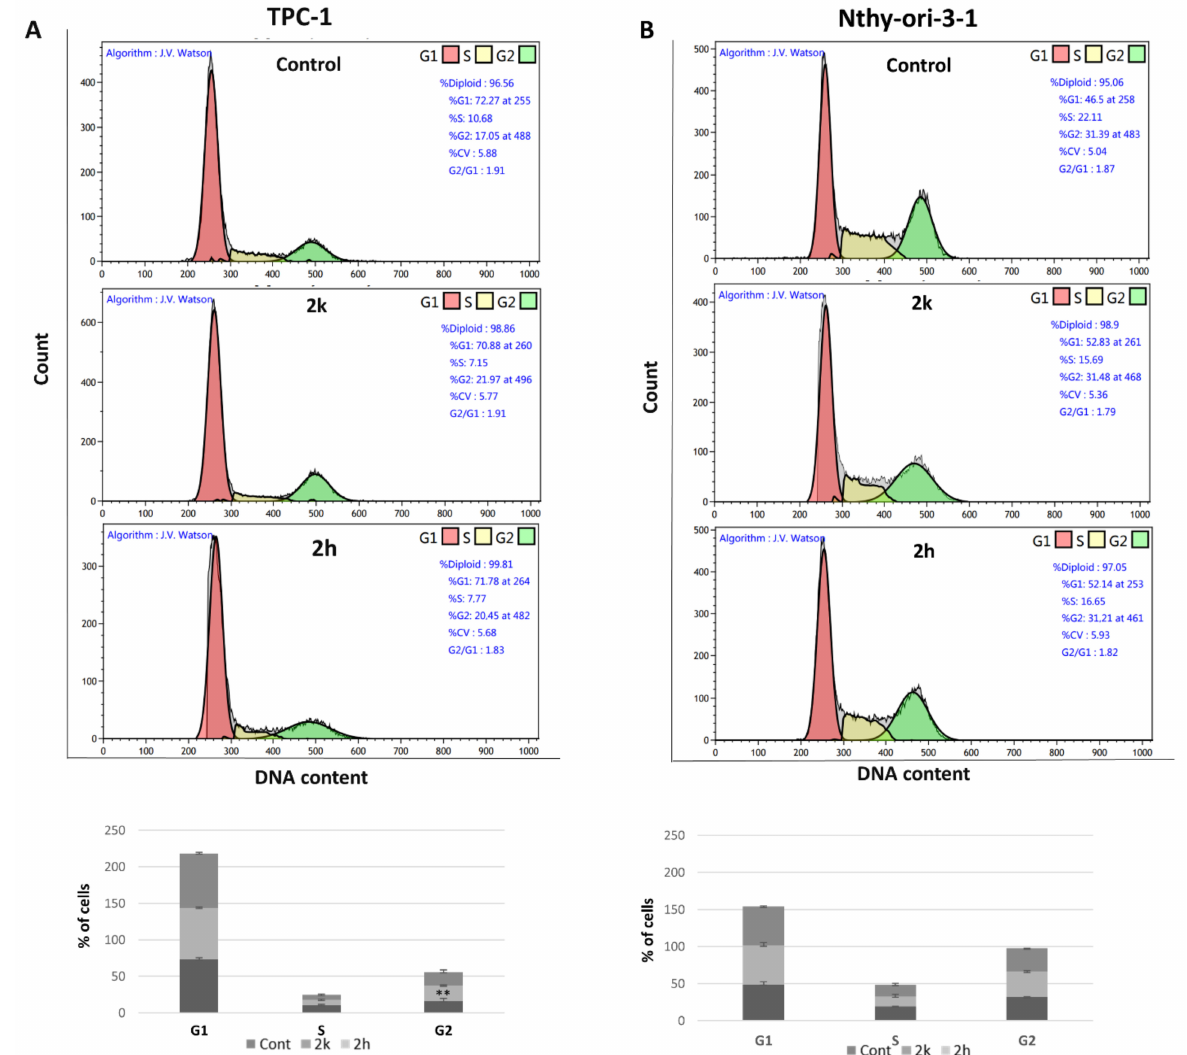
Figure 2. Flow cytometric analysis of coumarins 2k , 2h effects on TPC-1 and Nthy-ori-3-5 cell cycle. ( A ): representative profiles of the cell cycle and percentage of cells in various phases of the TPC-1 cell cycle. ( B ): representative profiles of the cell cycle and percentage of cells in various phases of the control cell cycle. Data represent the mean ± SD of three experiments. Statistical analysis was performed by Student t -test. ** p <